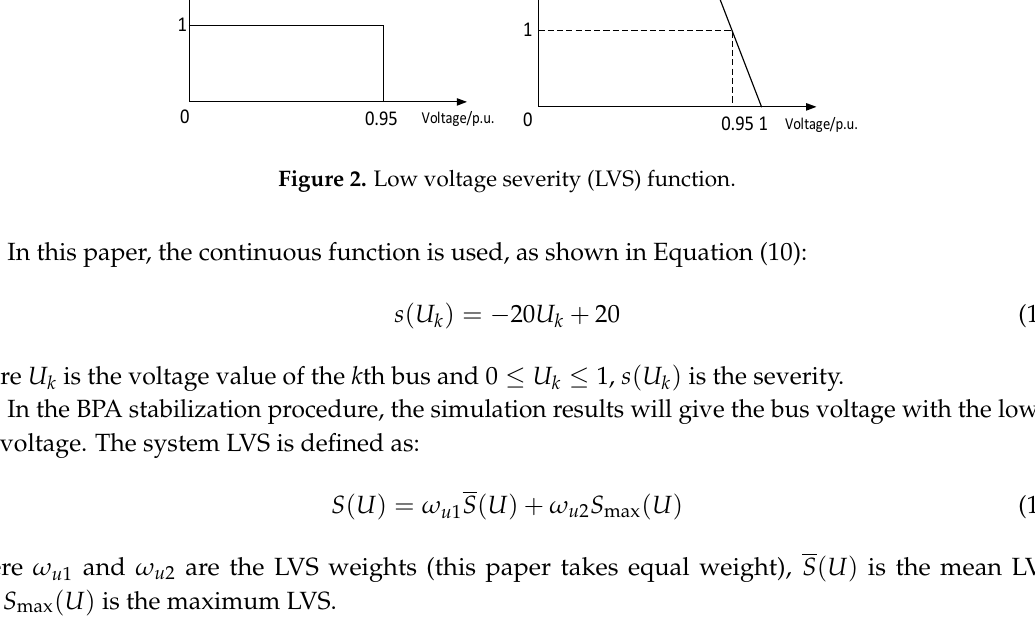
Figure 3. Power angle difference severity (PADS) function.